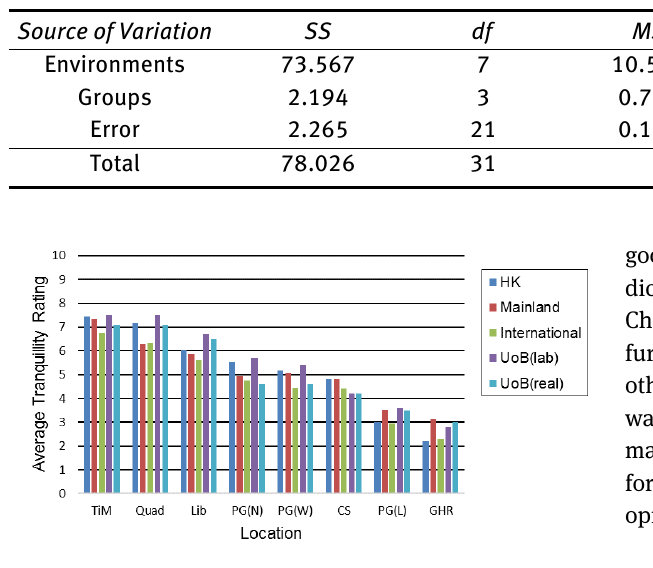
Table 4: Analysis of variance of laboratory ratings in UK and Hong Kong